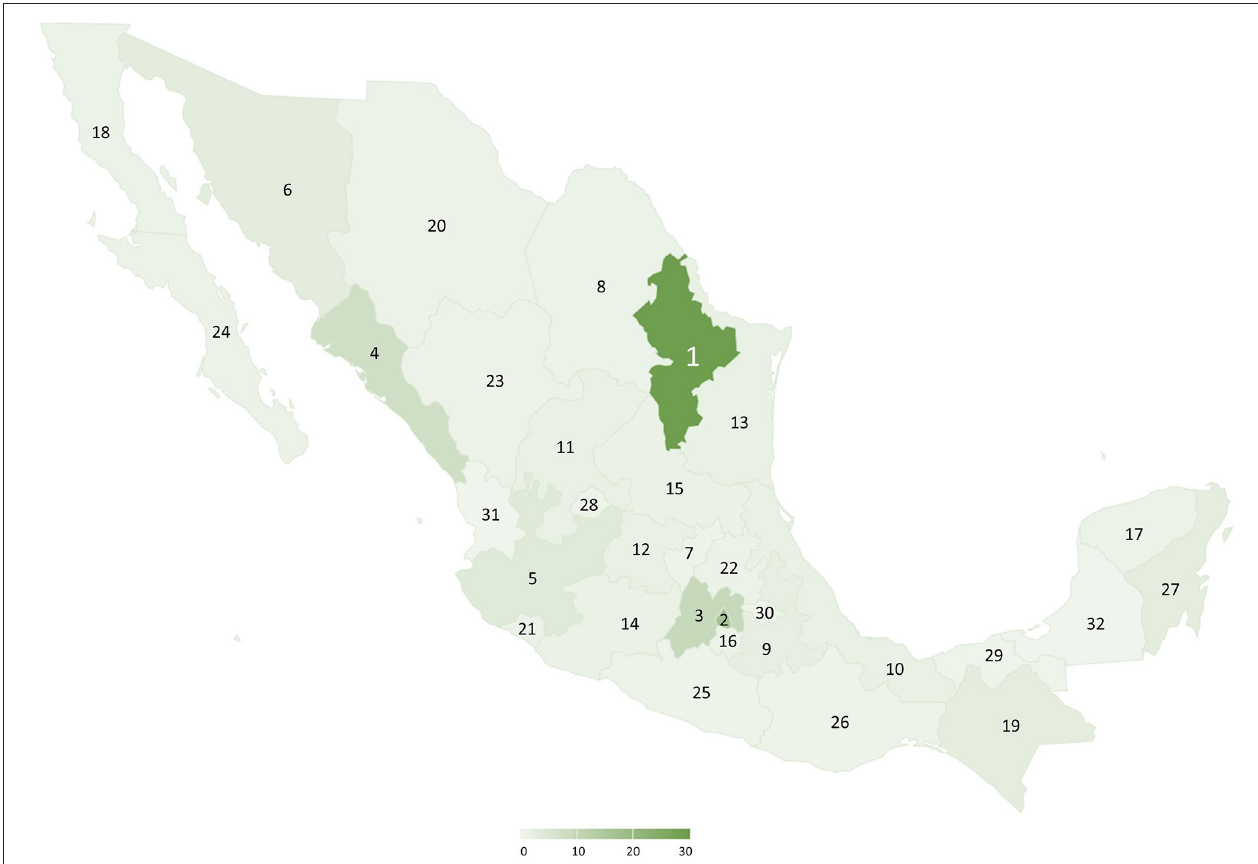
FIGURE 2 | Geographical origin of participants and percentage of participation per state: 1. Nuevo León 29.2%, 2. Mexico City 16.7%, 3. State of Mexico 9.5%, 4. Sinaloa 7.4%, and 5–32. Rest of the country 0–5%. Study of Coronavirus Disease-2019 (COVID-19) vaccines’ side effects in the Mexican population, August to September